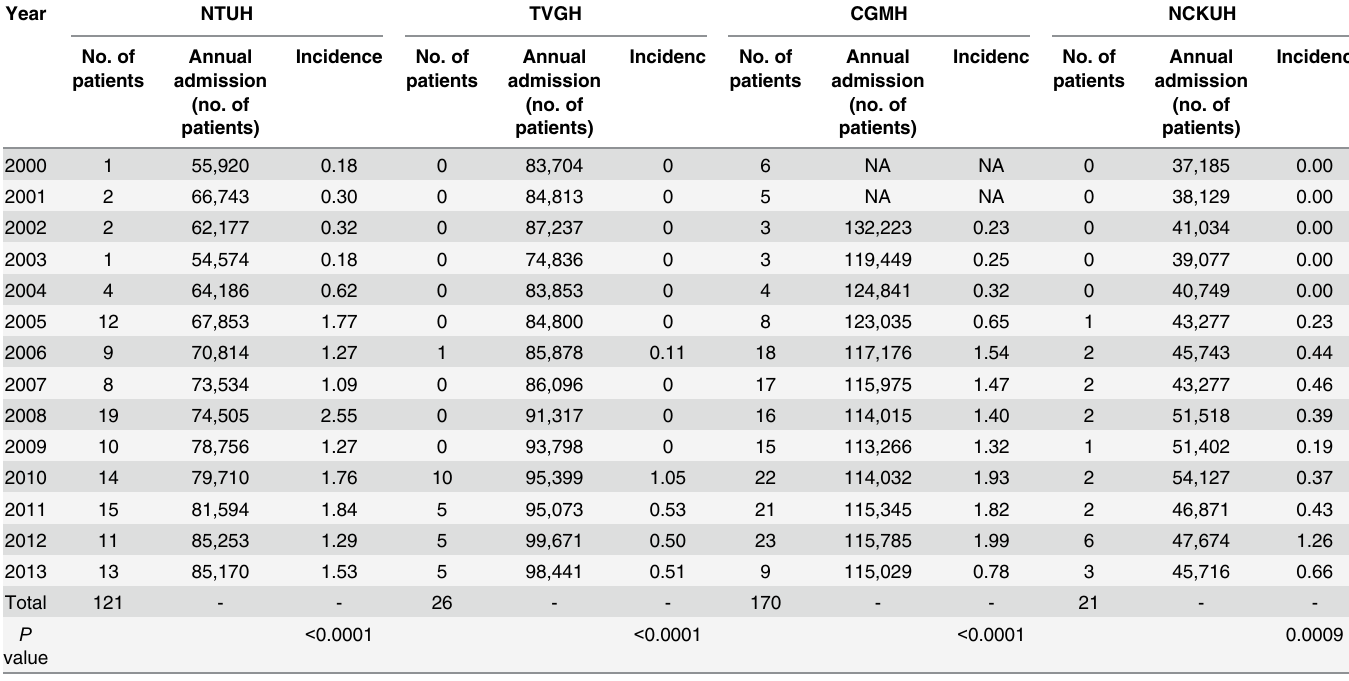
Table 1. Annual incidence (per 10,000 admissions each year) of invasive infection (bacteremia, meningitis, and peritonitis) caused by Listeria monocytogenes at four medical centers (n = 338) in Taiwan from 2000 to